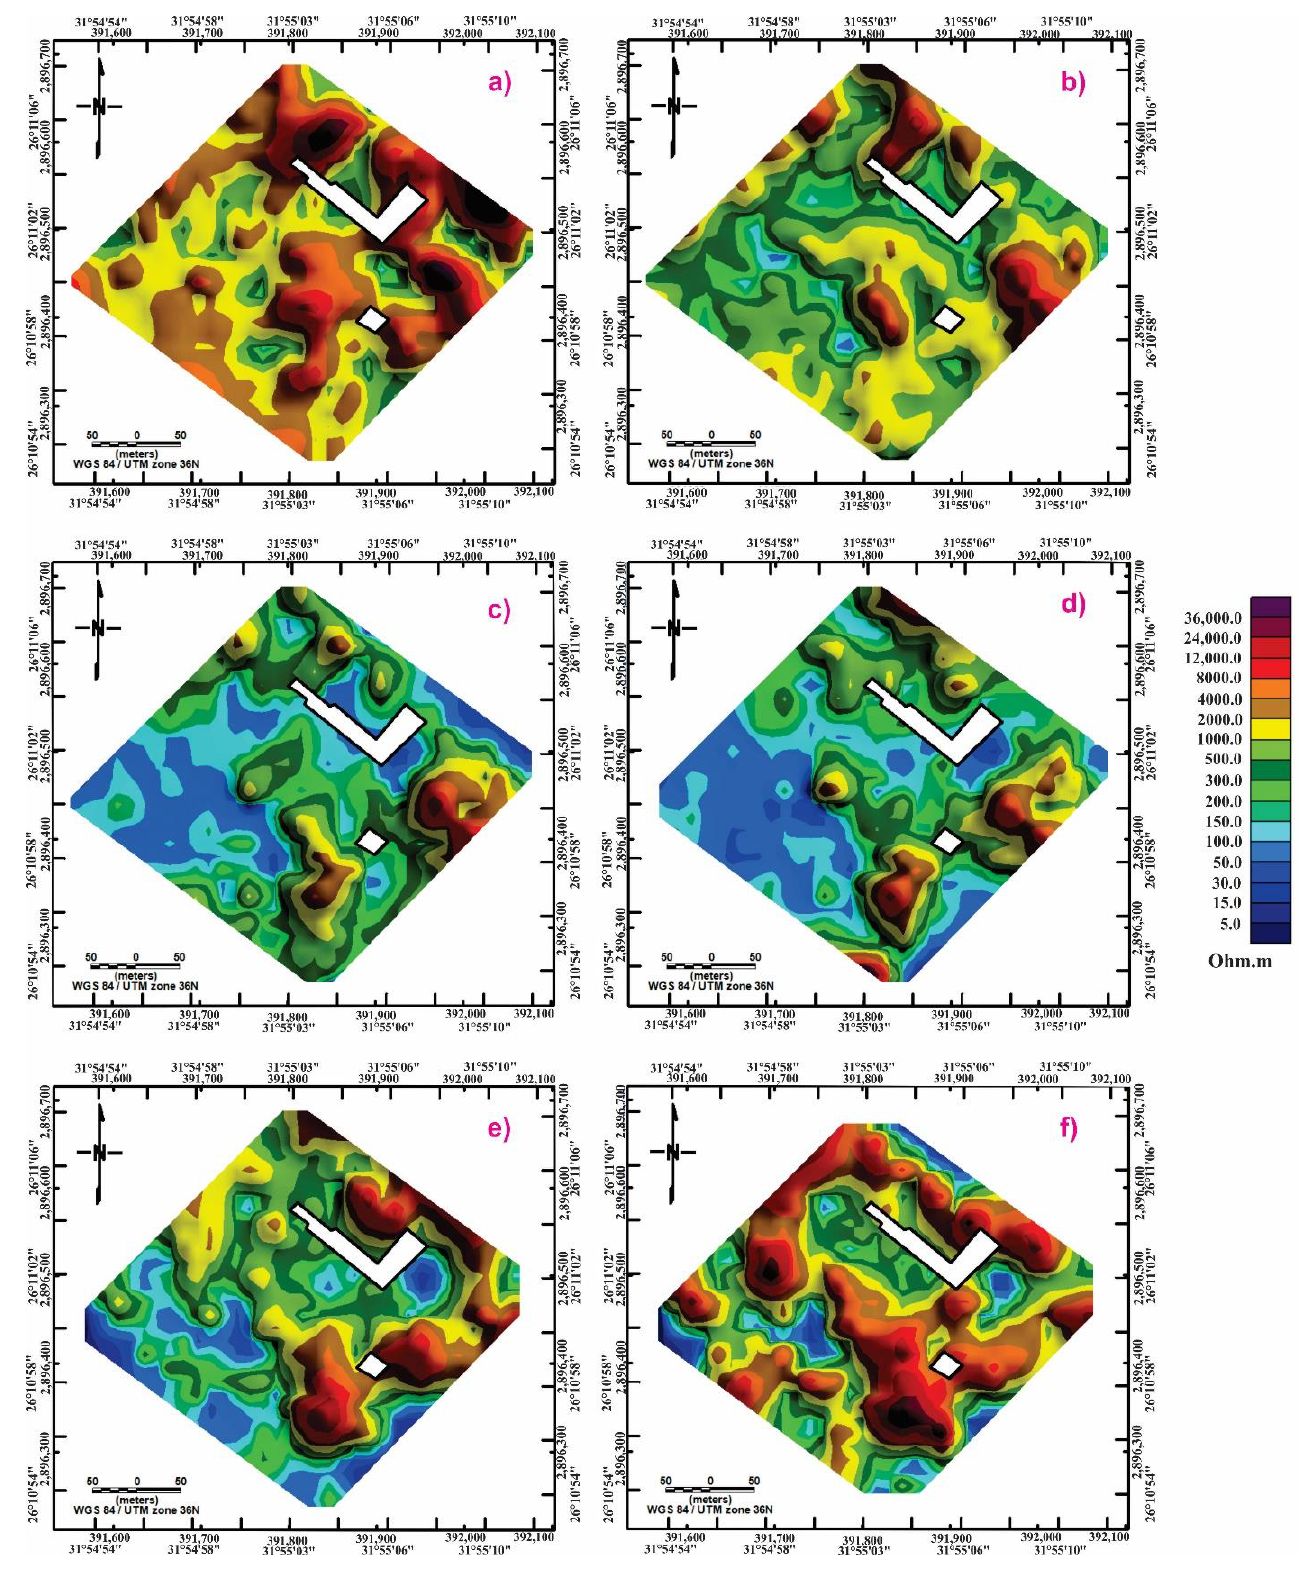
Figure 11. Horizontal slices of electrical resistivity at depths of ( a ) 0.51 m, ( b ) 3.8 m, ( c ) 6.53 m, ( d ) 9.85 m, ( e ) 16.16 m, and ( f ) 21.49 m from the ground surface that were sliced from the block diagram (Figure 9).